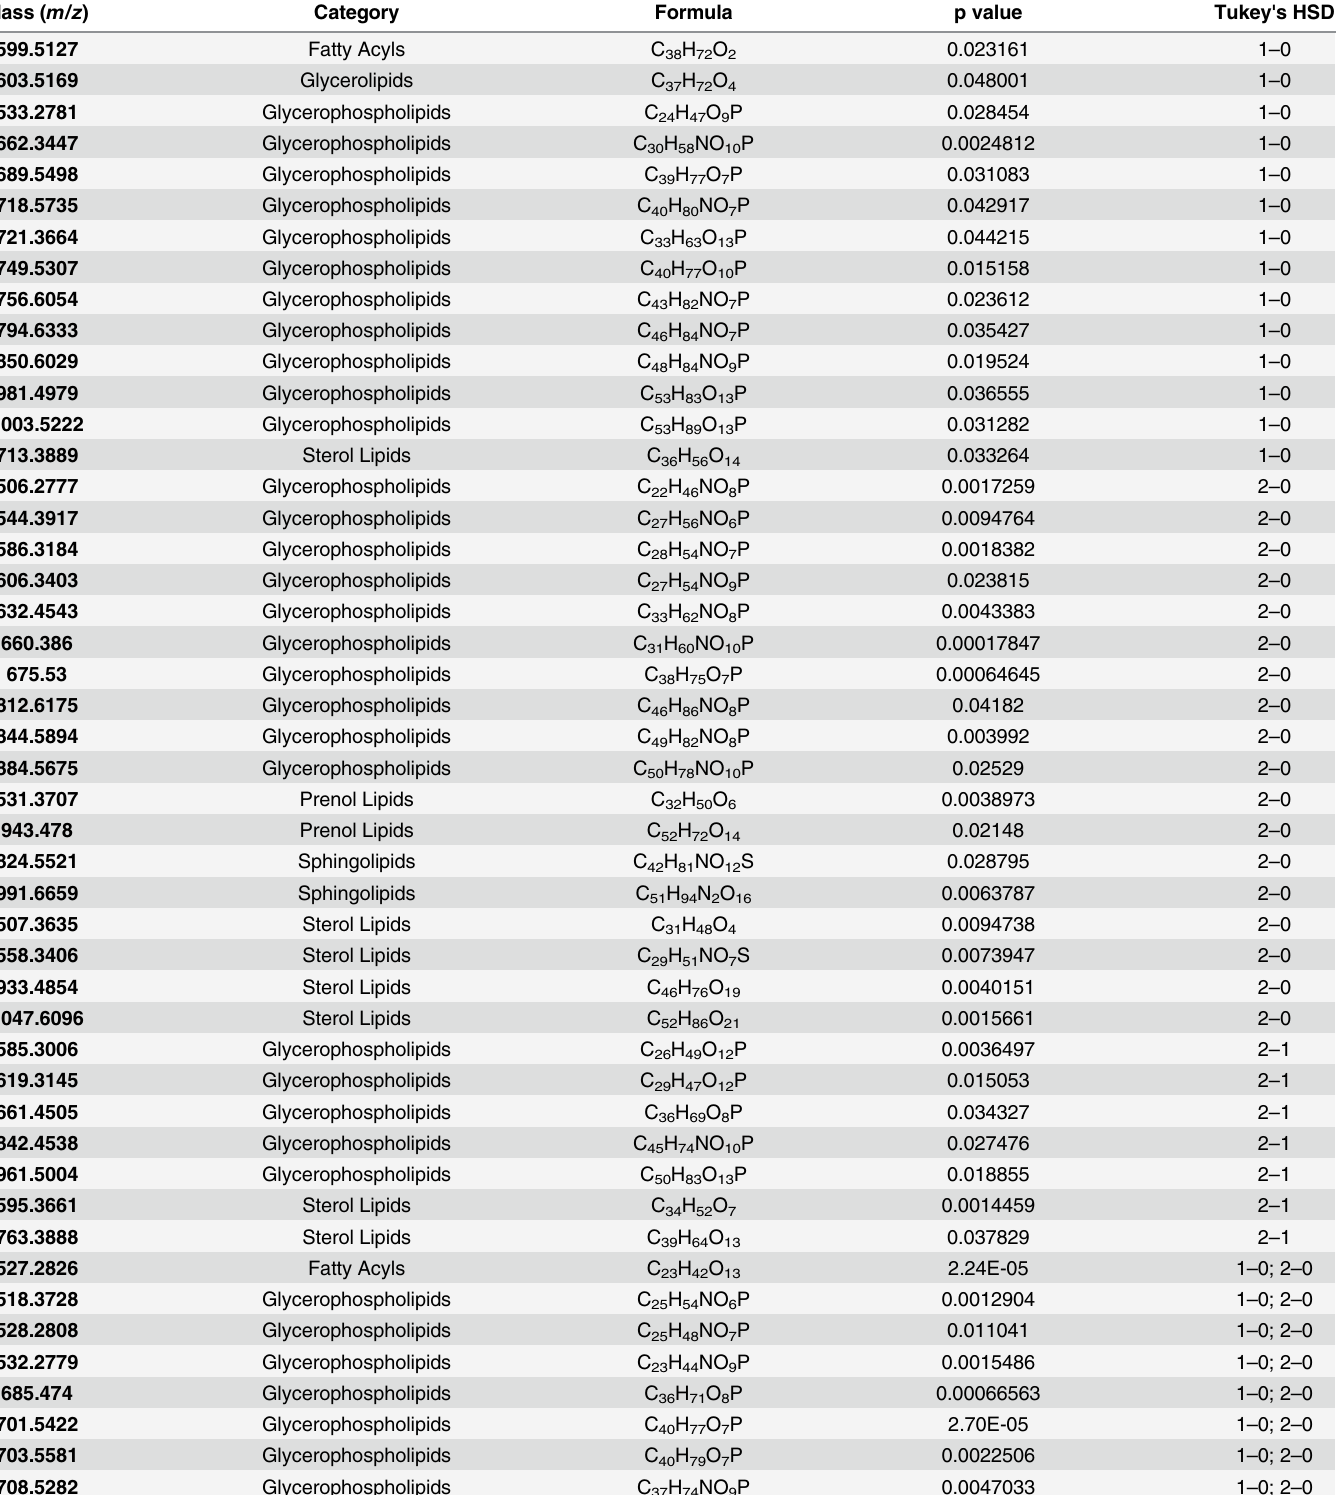
Table 2. Identified ions revealed by One-way ANOVA, sorting by Tukey ’ s HSD post-hoc